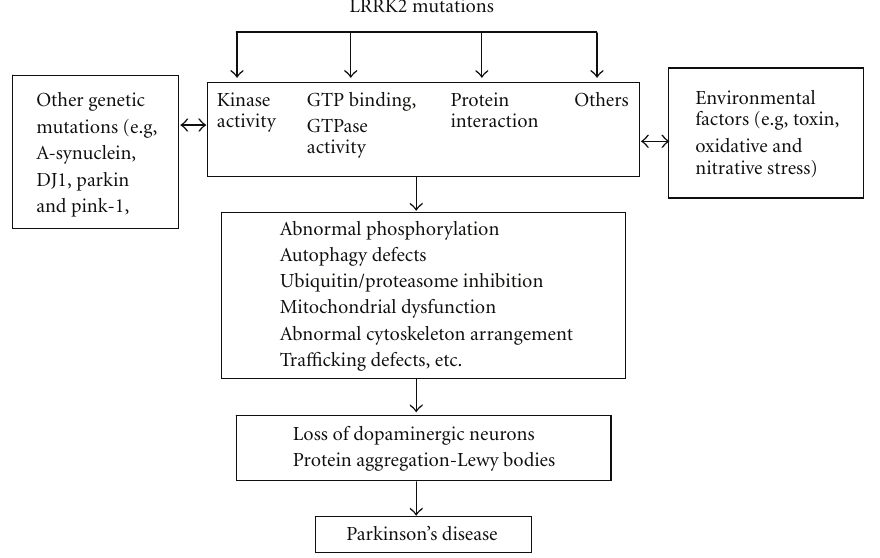
Figure 3: Potential pathways associated with LRRK2 in